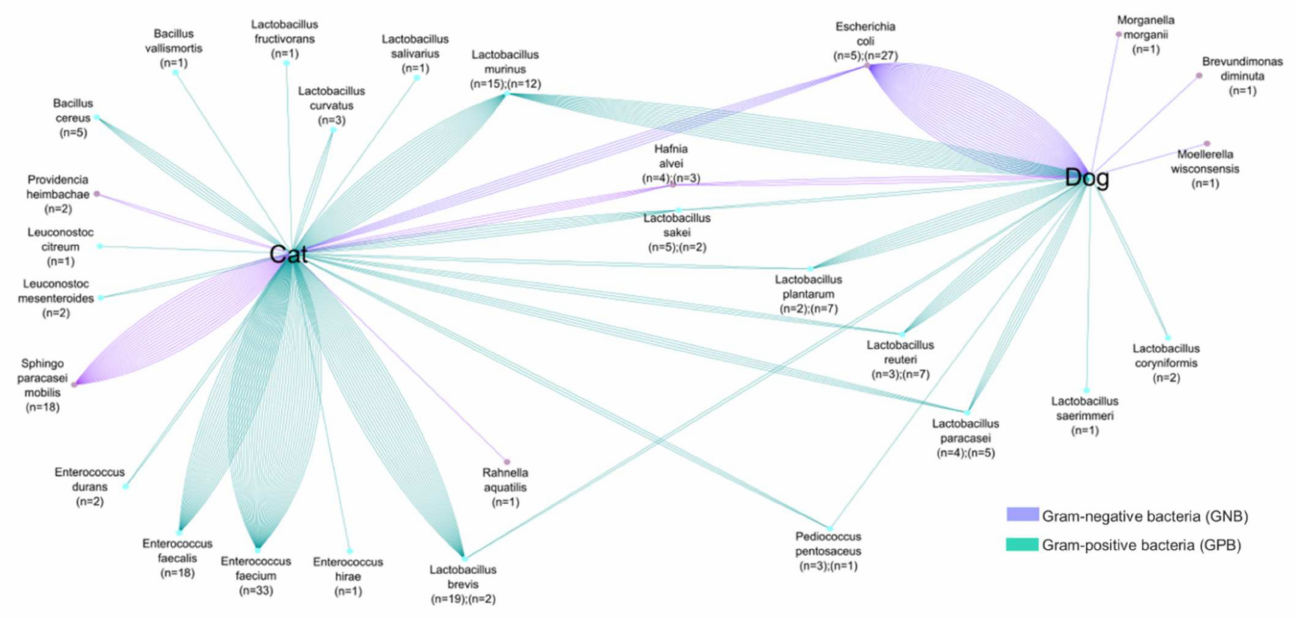
Figure 2. Illustration of colistin-resistant bacteria in the feces of dogs. ( A ). Distributed representation of colistin-resistant bacteria in a pie chart. ( B ). Distinguished colistin-resistant bacteria isolated in LBJMR. ( C ). Statistical analysis according to Gram status and colistin resistance.